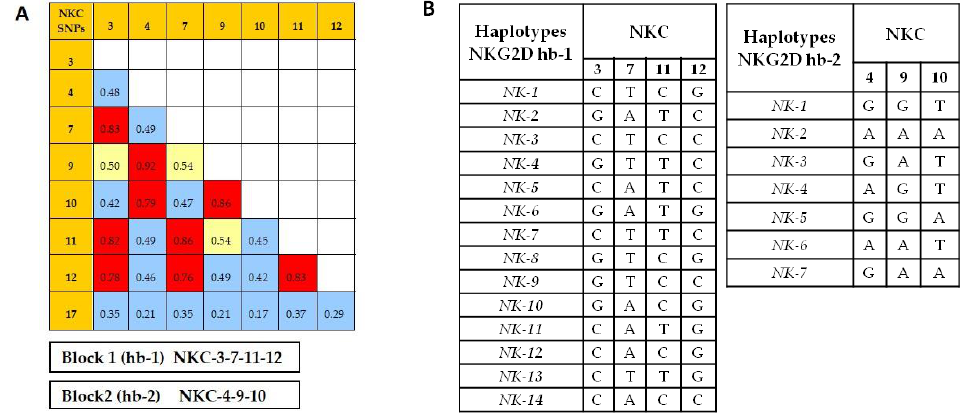
Figure 1. Linkage disequilibrium analysis between the eight NKC SNPs analyzed in melanoma patients in the Haploview software. ( A ) The r 2 values of the association with each SNP are represented: r 2 values > 0.7 (high grade of linkage disequilibrium) in red; r 2 values between 0.5 and 0.7 in yellow; and r 2 values < 0.5 in blue. ( B ) The two blocks of SNPs in close linkage are also represented; block Hb-1 including SNPs NKC3, NKC7, NKC11, and NKC12, and block Hb-2 including SNPs NKC4, NKC9, and NKC10.